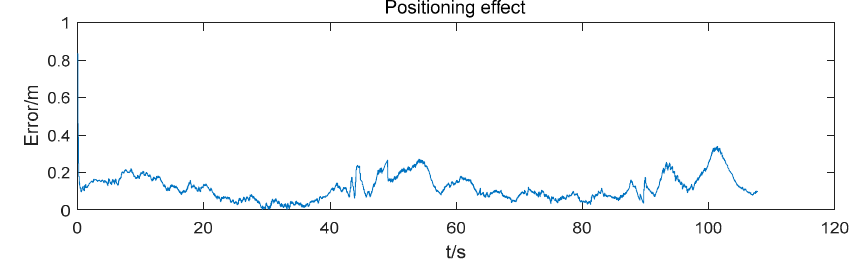
Figure 7. Positioning error using 4 anchors.